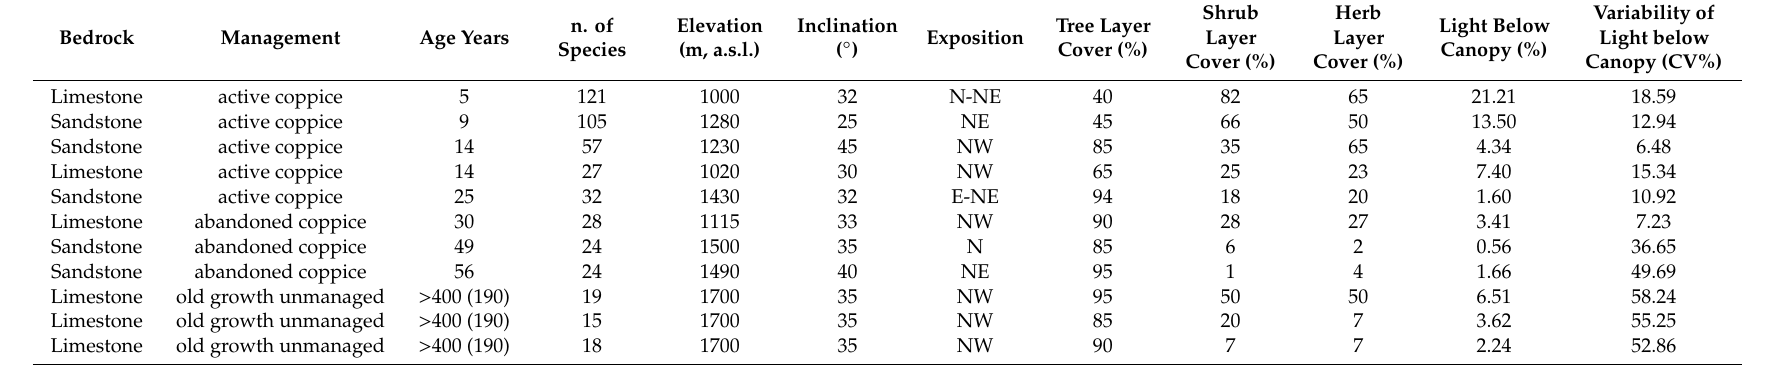
Table 1. Site features. “Age” is referred to as years since the last major disturbance. Old-growth forests experienced a major disturbance more than 400 years ago but had a minor thinning about 190 years ago. Light below canopy was measured with a PAR / LAI Ceptometer. Covers of vertical layers were estimated in a representative 20 m × 20 m plot in each